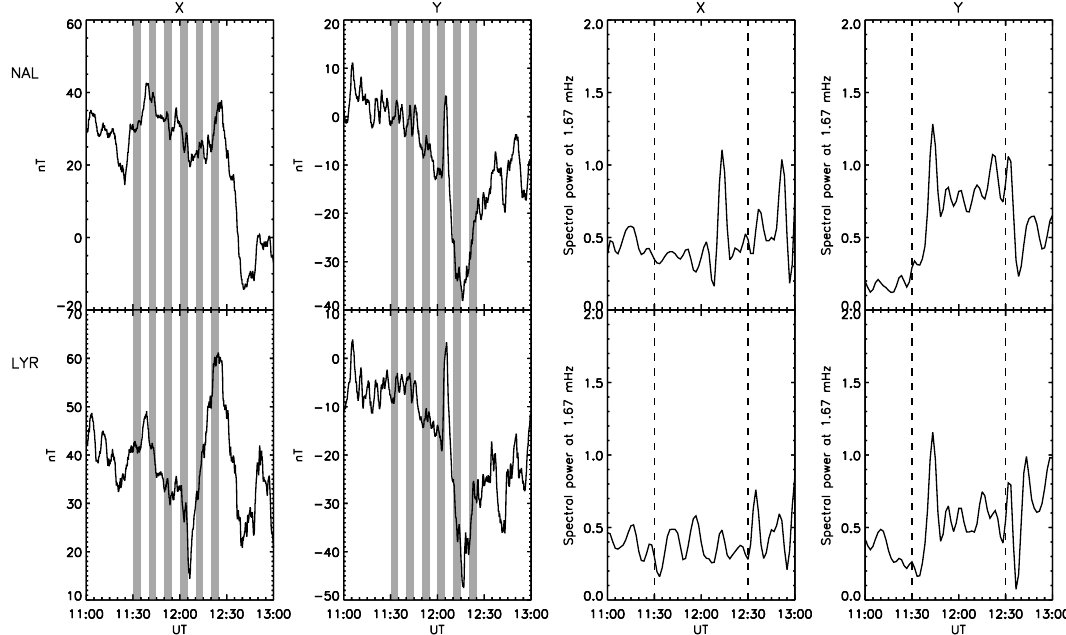
Figure 3 Fig. 3. Magnetic field data from ground magnetometers at (top) Ny ˚Alesund (NAL), and (bottom) Longyearbyen (LYR) during 11:00– 13:00UT on 1 February 2006. The X (geographic north) and Y (geographic east) components of the field are plotted in the first and second columns respectively. These data have had the day mean value subtracted. The grey shaded regions indicate the SPEAR on times, each lasting 5min. The third column shows the spectral power at 1.67mHz in the X component at each station, obtained using a sliding window of 4000s length as described in the text. The vertical dashed lines mark the interval of SPEAR heating from 11:30–12:30UT. The plots in the fourth column similarly show the spectral power at 1.67mHz in the Y component of the